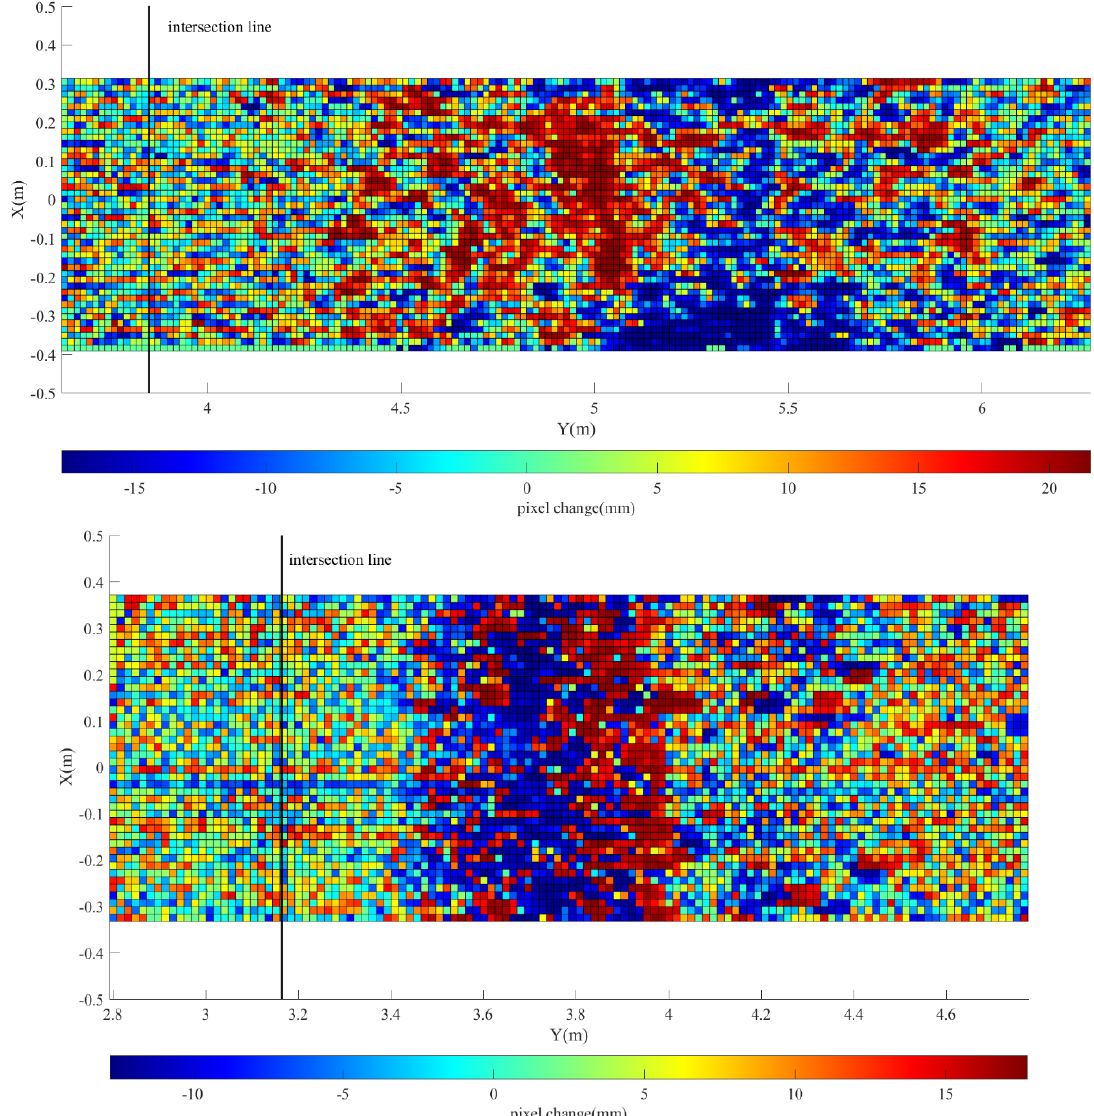
Figure 10. More detailed raster image of changes before and after the wave attack (top for slope 1 and bottom for slope 2). Pixels are colored by the change